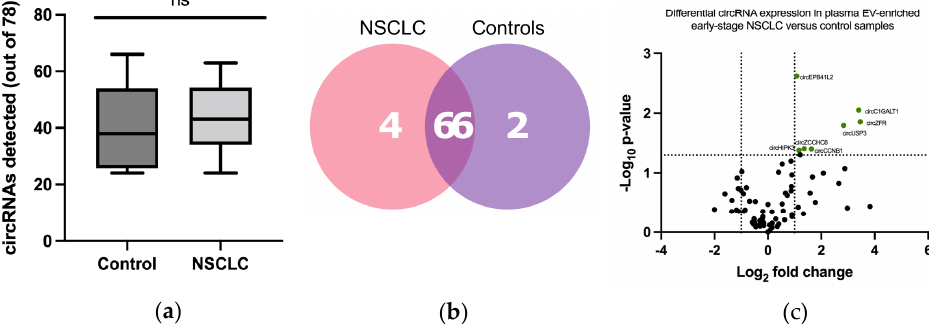
Figure 5. EV-circRNA detection and differential expression analysis. ( a ) Number of circRNAs de- tected in extracellular vesicle (EV) enriched samples from cancer patients and non-cancer controls using our custom circRNA nCounter panel, which targets 78 circRNA (Mann–Whitney U test, p = 0.3807); ( b ) Venn diagram displaying circRNAs identified in early-stage NSCLC and non-cancer controls, featuring those shared by both cohorts; ( c ) Differential expression analysis of log 2 -normalized counts between the early-stage NSCLC and control EV samples. circEPB41L2, circC1GALT1, circZFR, circUSP3, circZCCHC6, circHIPK3 and circCCNB1 were found upregulated in NSCLC samples.